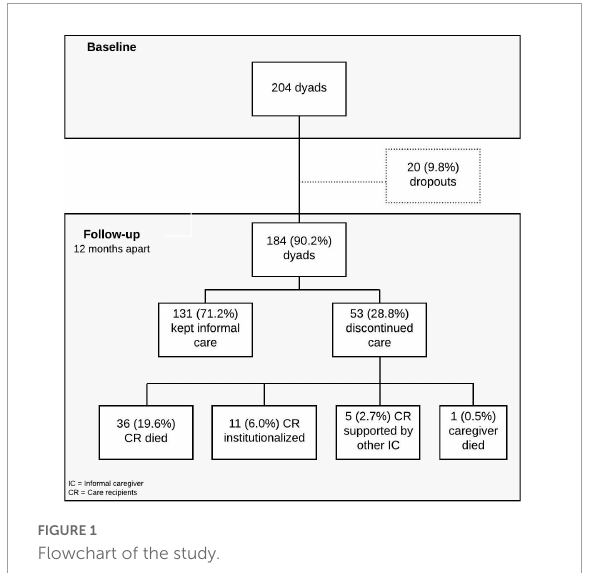
FIGURE1 Flowchart of the